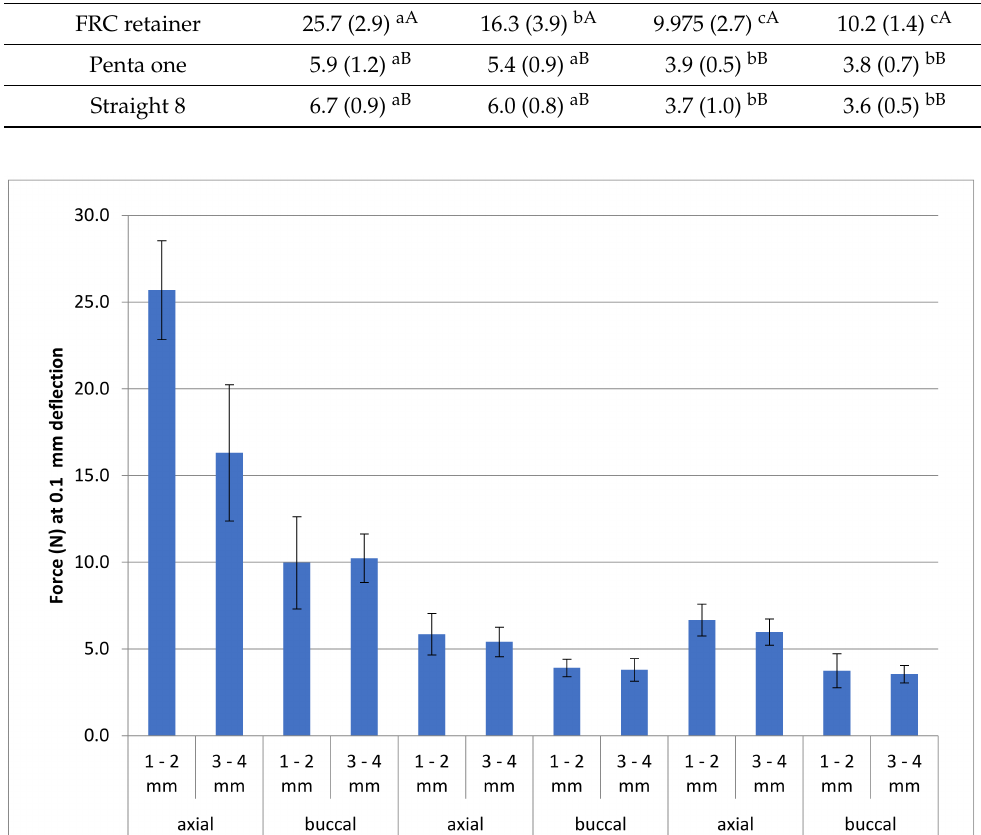
Figure 7. The descriptive results for the load values with standard deviation (vertical bars) at 0.1 mm magnitude of movement of the 12 groups (n = 7) of FRC retainers and metal retainers (Penta One 0.0215 inches and Straight 8 0.028 inches × 0.008 inches retainers). The test was carried out from the buccal or axial